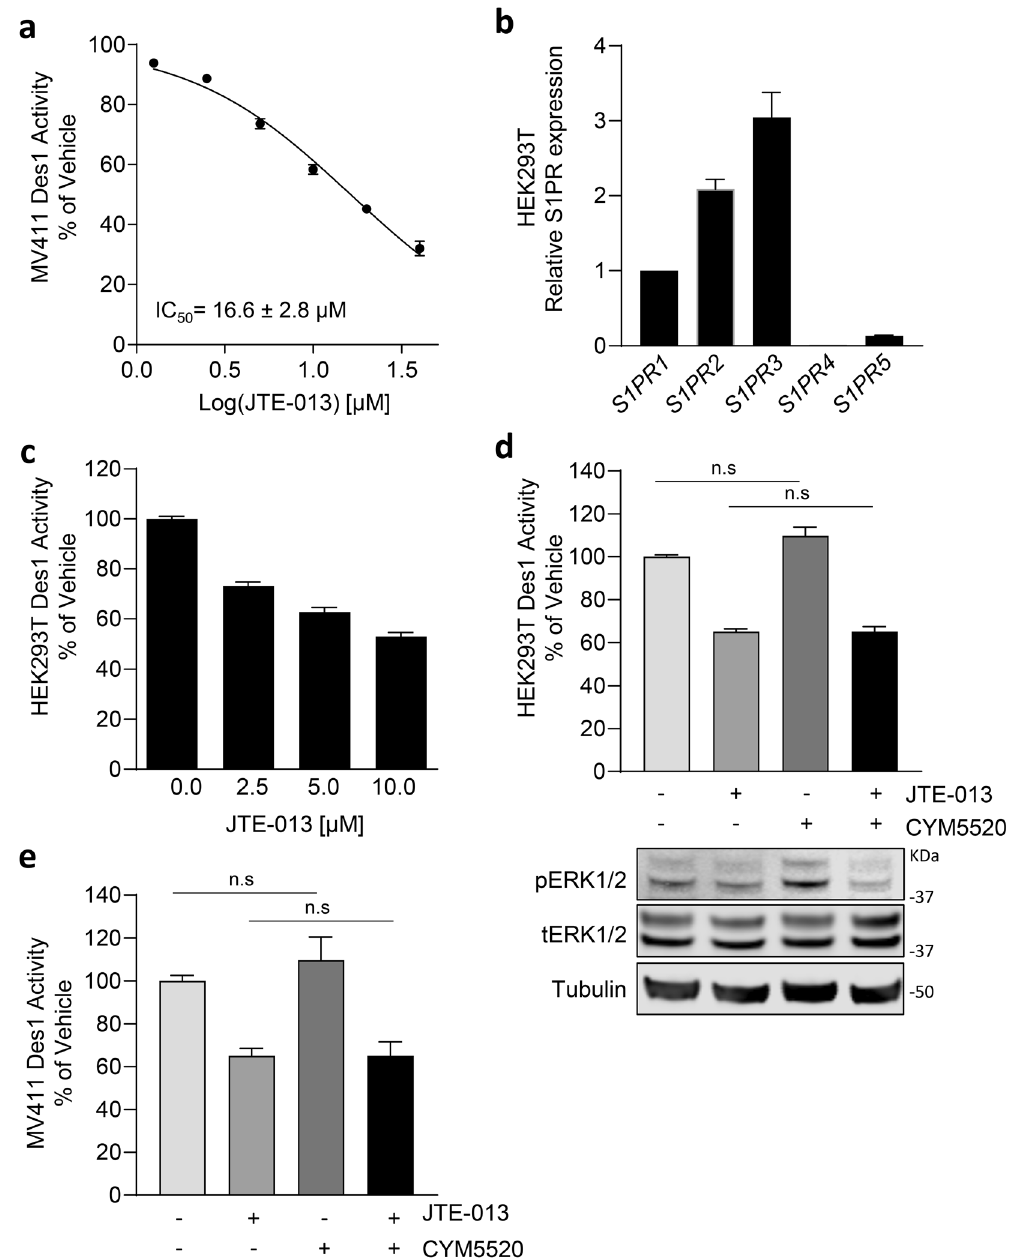
Figure 2. JTE-013 inhibits Des1 activity independently of S1P 2 receptor. ( a ) MV411 cells were labelled with dhCer and treated with either vehicle control (DMSO, 0.1% final) or varying doses of JTE-013 (40, 20, 10, 5, 2.5, 1.25 µM) in 0.5% FBS/RPMI media for 3 h prior to analysis by HPLC. IC 50 data was determined using non- linear regression. ( b ) QPCR analysis of HEK293T cells to detect expression of S1P receptor mRNA. Results are presented relative to S1P 1 and are representative of triplicate measurements in two independent experiments, mean ± SEM. ( c ) HEK293T cells were labelled with NBD-C6-dhCer and treated with either vehicle control (DMSO, 0.1% final) or varying doses of JTE-013 (10, 5, 2.5, 1.25 µM) in 0.5% FBS/DMEM media for 2 h prior to analysis by HPLC. ( d ) To test if S1P 2 agonism could rescue JTE-013-induced Des1 inhibition, HEK293T cells were labelled with NBD-C6-dhCer and treated with either vehicle control (DMSO, 0.2% final), 10 µM JTE-013, 10 µM S1P 2 agonist CYM5520 or both in 0.5% FBS/DMEM media for 2 h prior to analysis by HPLC. To confirm agonism of S1P 2 , HEK93T cell lysates from the treatment groups were subjected to SDS-PAGE and western blotting to detect phospho-ERK1/2 (upper panel), total ERK (middle panel) with tubulin as a loading control (bottom panel). Full immunoblots are shown in Supplemental Fig. S2. ( e ) MV411 cells were labelled with NBD-C6-dhCer and treated with either vehicle control (DMSO, 0.2% final), 10 µM JTE-013, 10 µM S1P 2 agonist CYM5520 or both in 0.5% FBS/DMEM media for 3 h prior to analysis by HPLC. All Des1 data is displayed as a percentage Des1 activity relative to vehicle control; mean ± SEM (n = 3). Statistical significance was determined by Student’s t-test; ( p value *< 0.05, **< 0.01), n.s. not